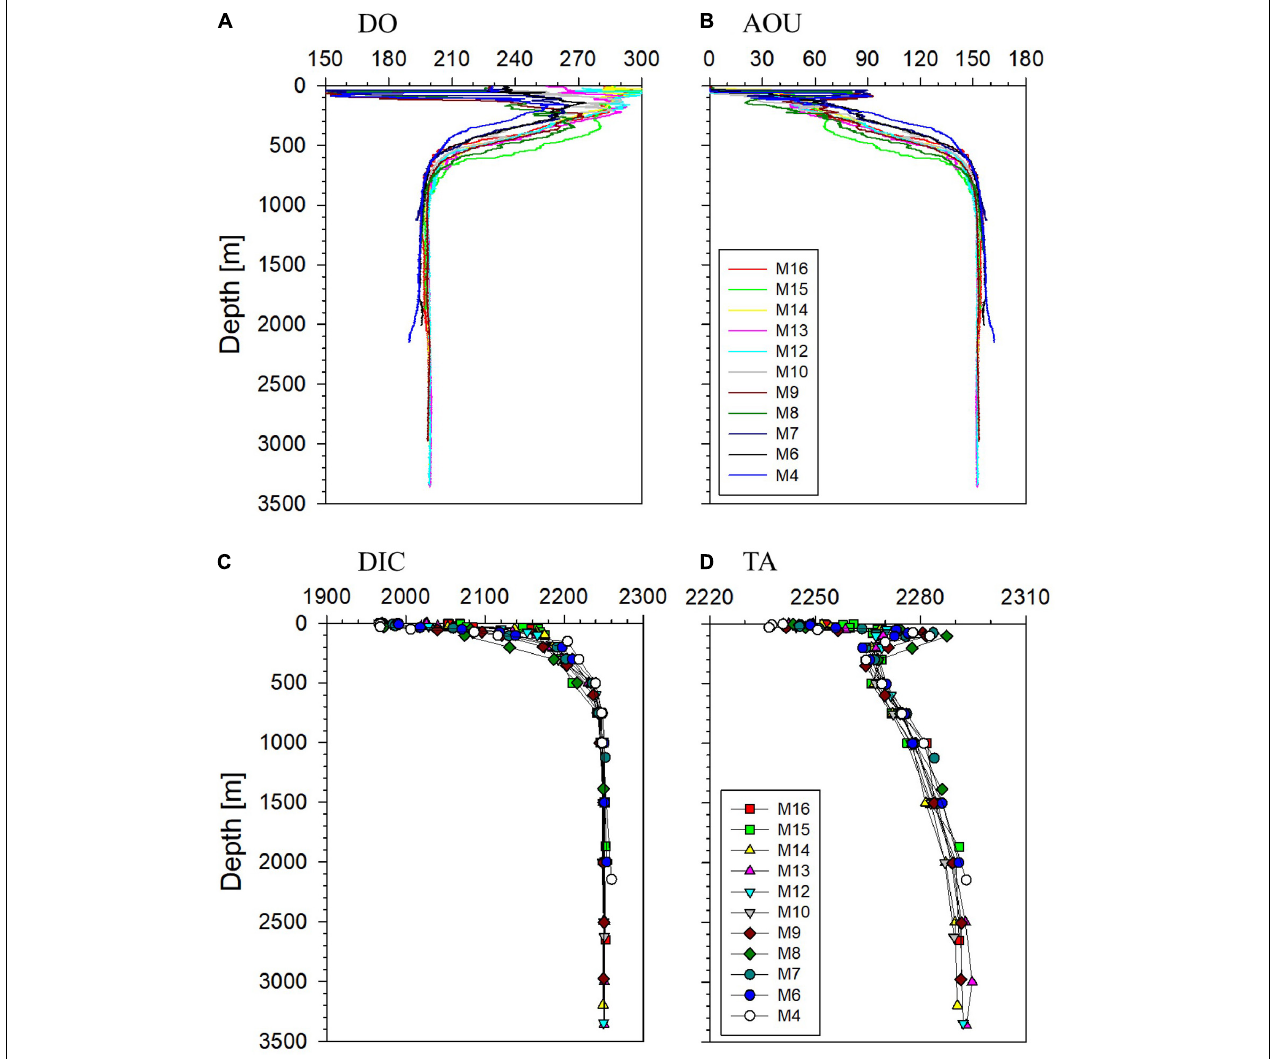
FIGURE 2 | Vertical distributions of (A) dissolved oxygen (DO), (B) apparent oxygen utilization (AOU), (C) dissolved inorganic carbon (DIC), and (D) total alkalinity (TA) at the stations along the western most transect. All results are presented in µ mol kg − 1 .